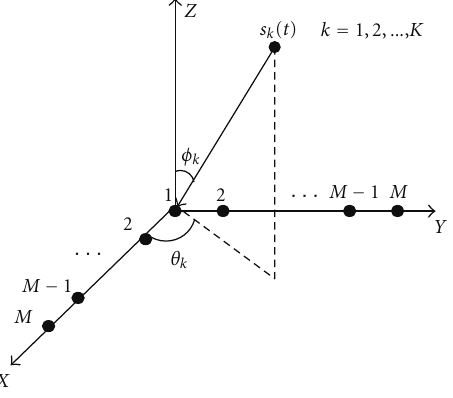
Figure 1: The structure of L-shaped